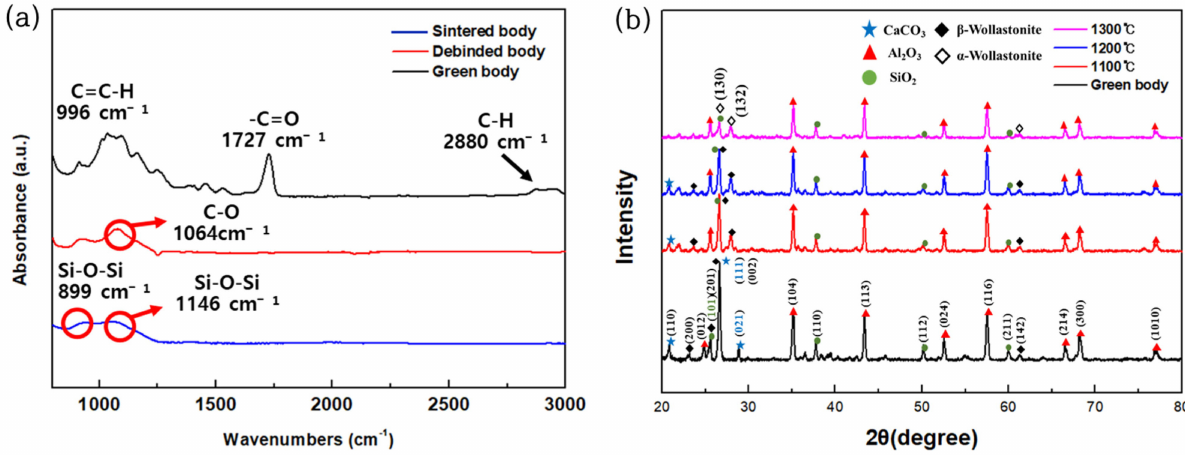
Figure 5. ( a ) FTIR spectra of the ceramic after pyrolysis at different temperatures, ( b ) XRD patterns of the ceramic bodies according to different sintering